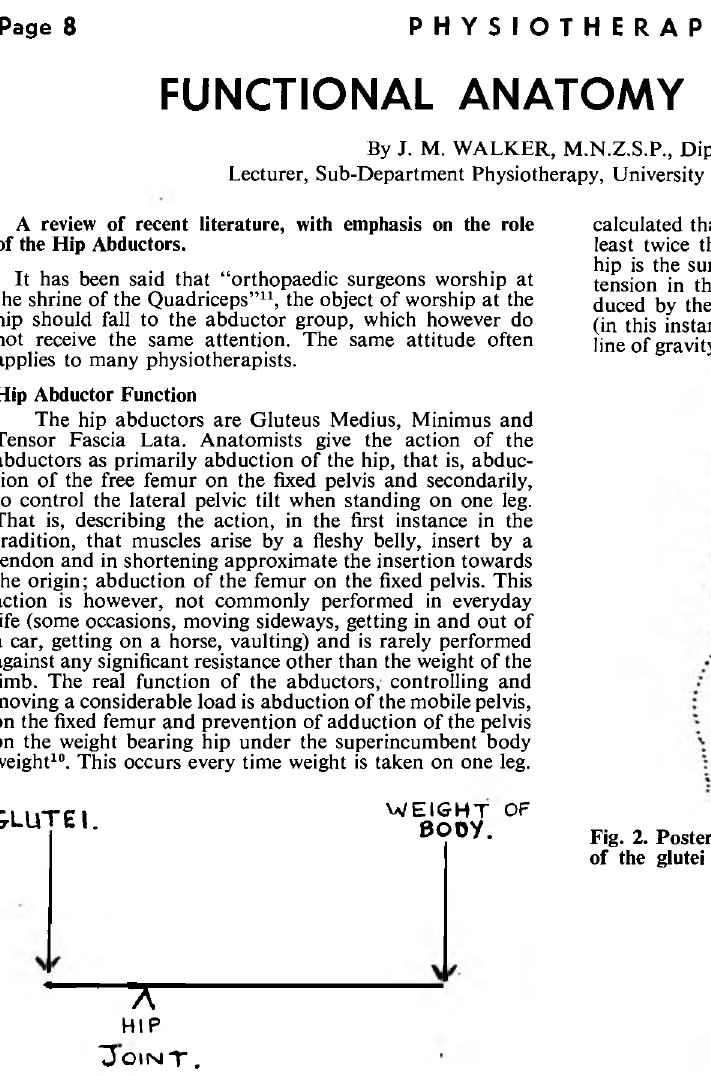
Fig. 1. The lever principle of the hip joint.